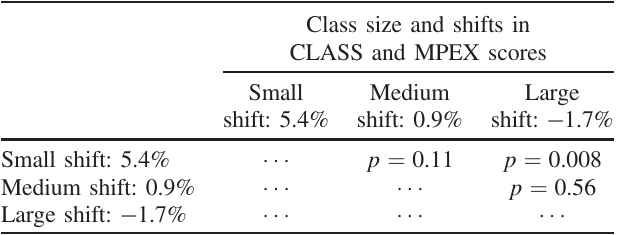
TABLE VIII. Results of Tukey-HSD post hoc pairwise con- trasts comparing shifts for different class sizes. Small classes have statistically significant greater positive shifts than large